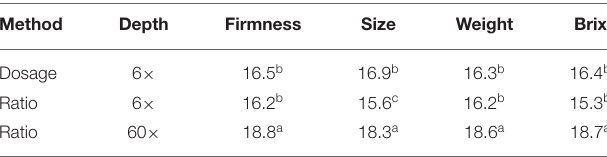
A post-hoc Tukey test (alpha = 0.05) was used for intergroup comparisons over the scenarios. Cells with the same letter represent non-statistically different groups for the given trait